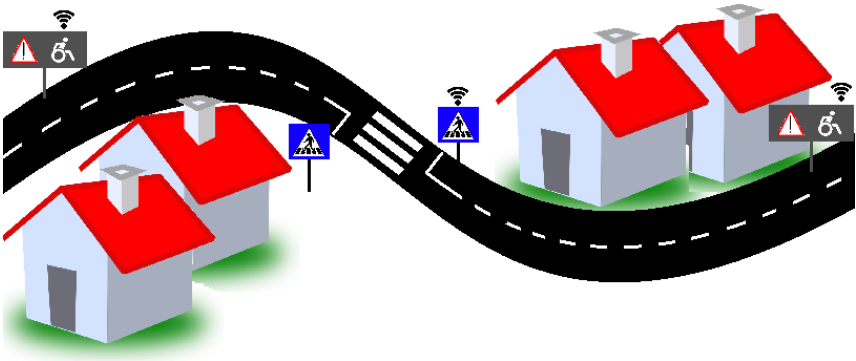
Figure 15. Application scenario with a double curve road city and four road